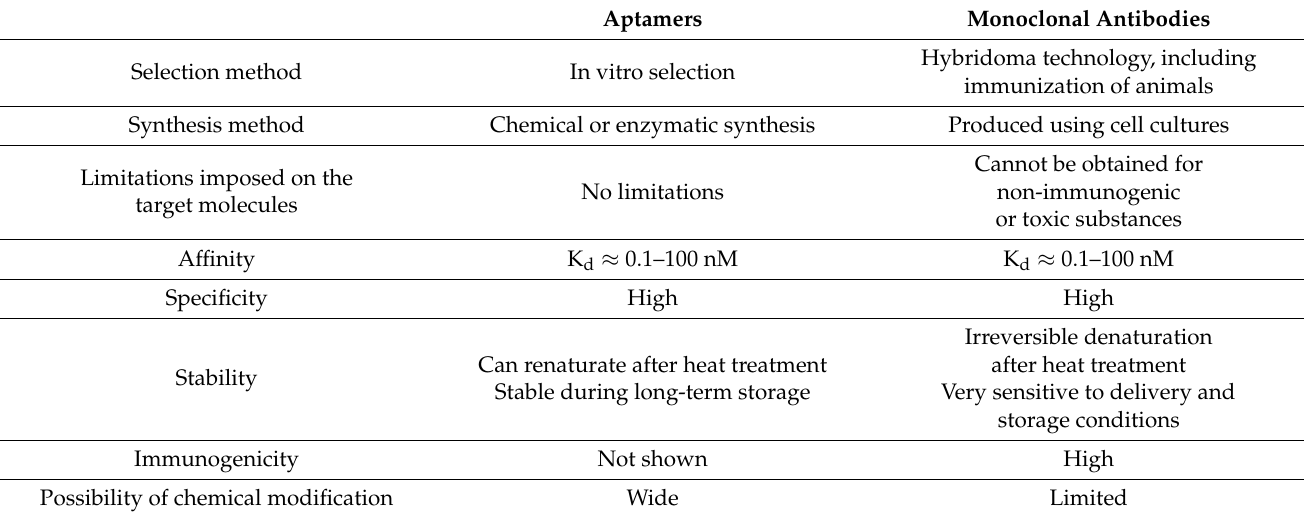
Table 1. Comparison of aptamers and monoclonal